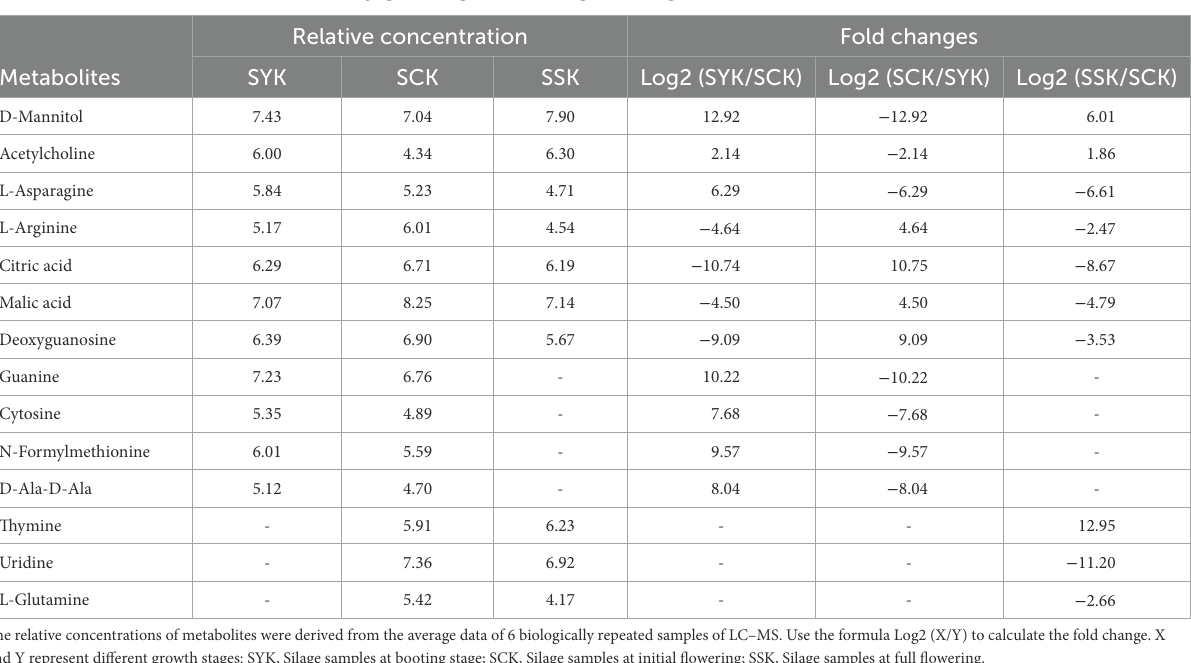
TABLE 3 The main differential metabolites of ryegrass silage at different growth stages.